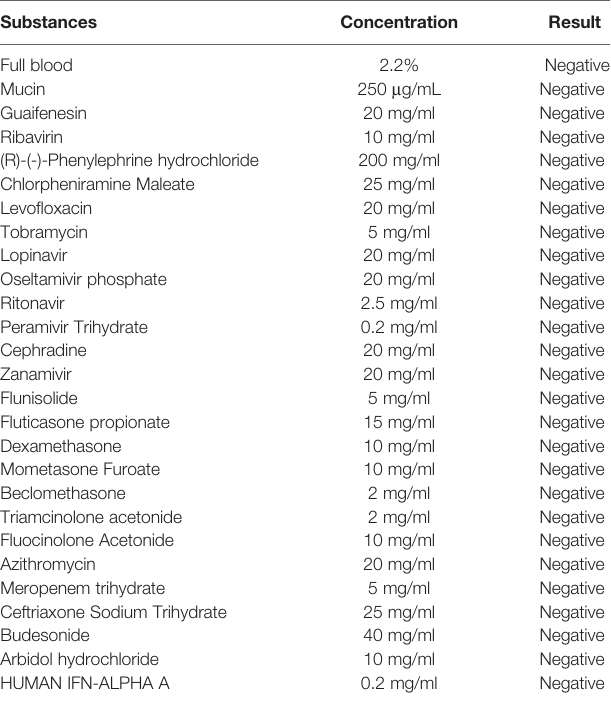
TABLE 2 | Concentration table of interfering substances.